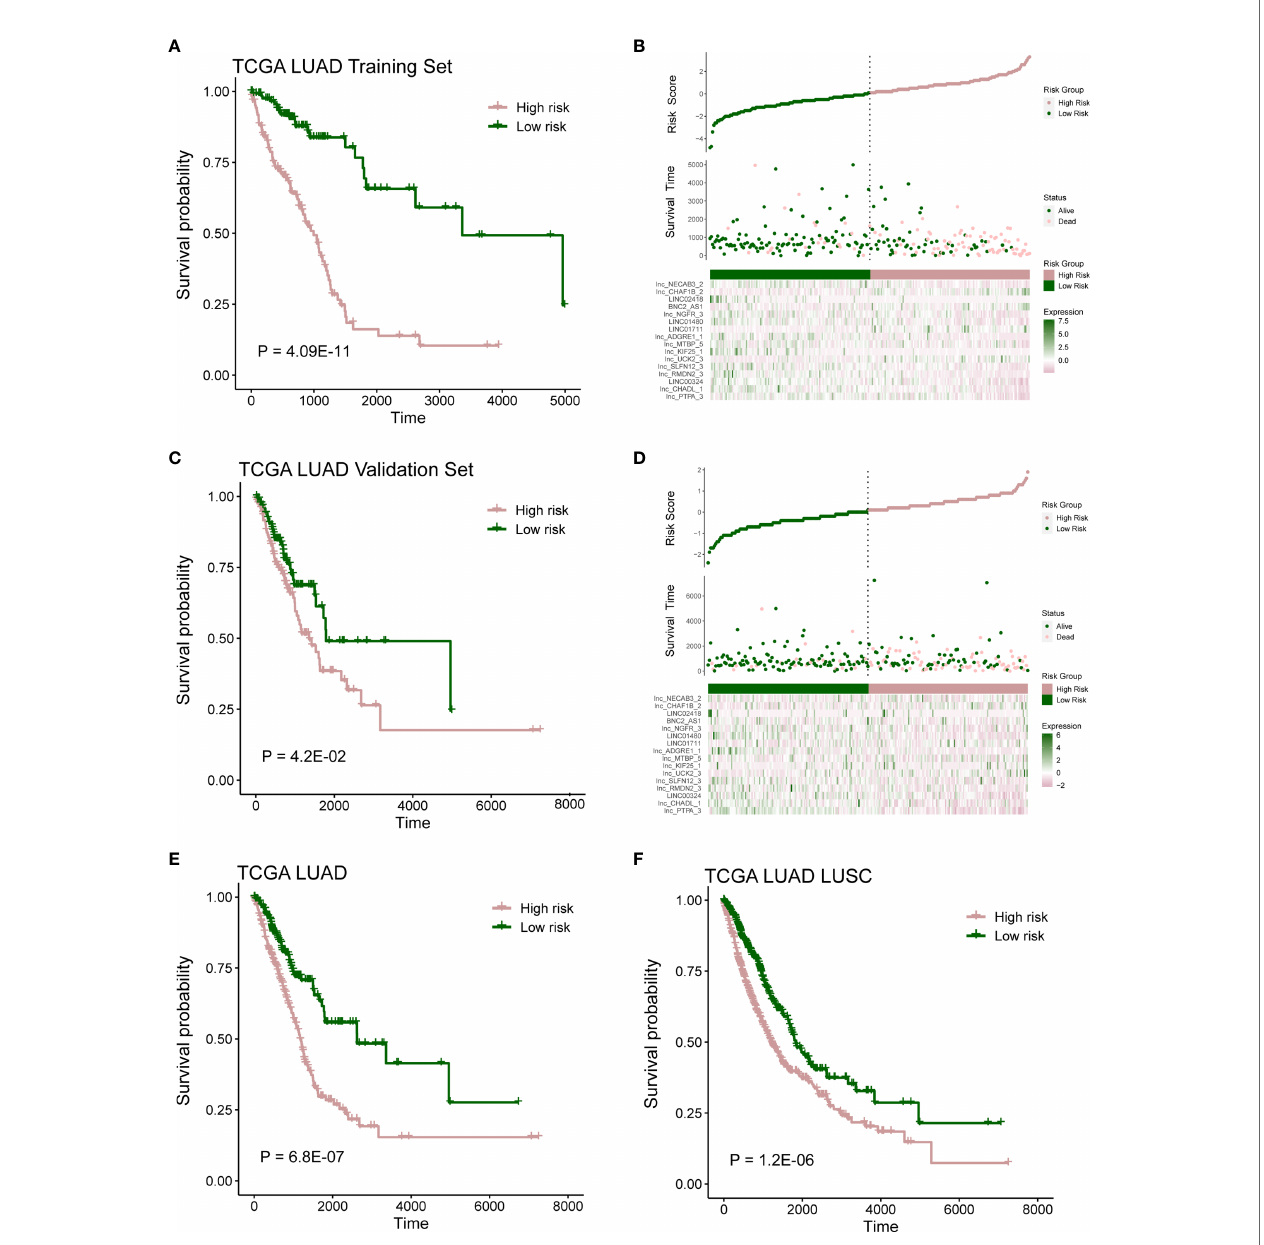
FIGURE 3 | Prognostic model capable of distinguish patients. (A) Survival analysis between high- and low-risk samples in TCGA LUAD training cohort. (B) Distribution of survival time and risk scores, which were calculated based on the expression of 16-lncRNA prognostic model in TCGA LUAD training cohort. (C) Survival analysis in TCGA LUAD validation cohort. (D) Distribution of survival time and risk scores, which were calculated based on the expression of 16-lncRNA prognostic model in TCGA LUAD validation cohort. (E, F) Survival analysis in TCGA LUAD cohort or TCGA lung cancer (including LUAD and LUSC)